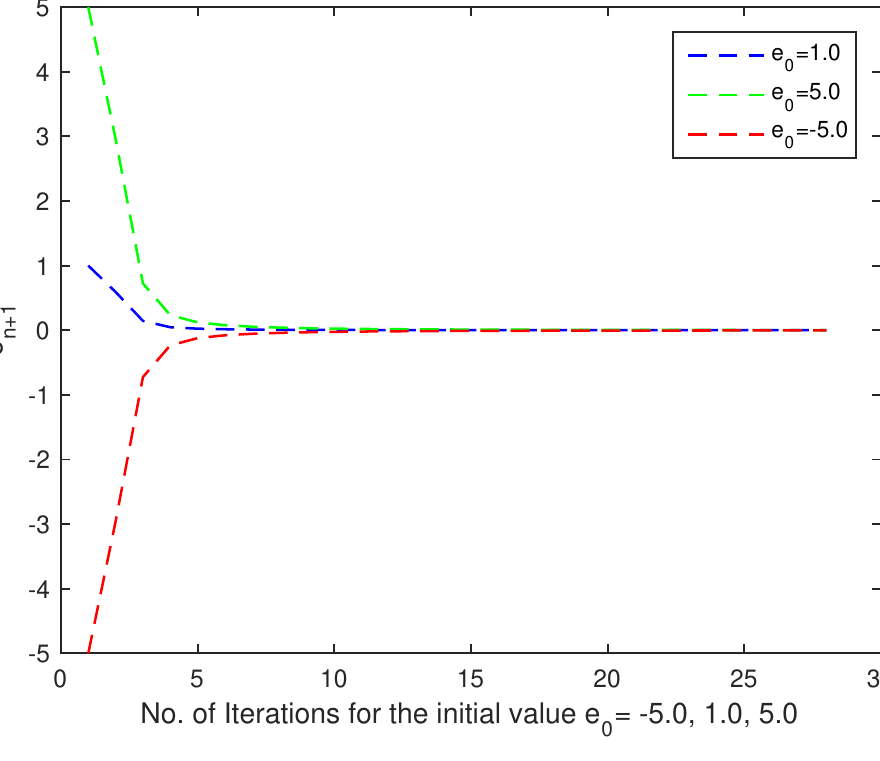
Figure 1. Graphical representation of convergence of sequence { e n } with different initial values e 0 = 1, − 5.0 and